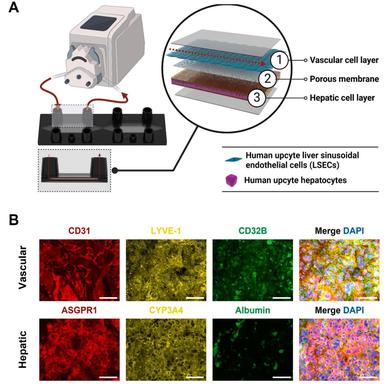
Schematic outline and morphological analysis of the Dynamic42 3D model. (A) Assembled 3D model in the Dynamic42 biochip under unidirectional vascular perfusion (red arrows). Models contain a vascular cell layer (1) formed by expanded upcyte® LSECs (donor 462) and an opposed hepatic layer (3) consisting of upcyte® hepatocytes (donor 732–03). Both cell layers are separated by a porous membrane (2). Figures were created with BioRender.com. (B) Immunofluorescence staining of control-treated models after 7 days